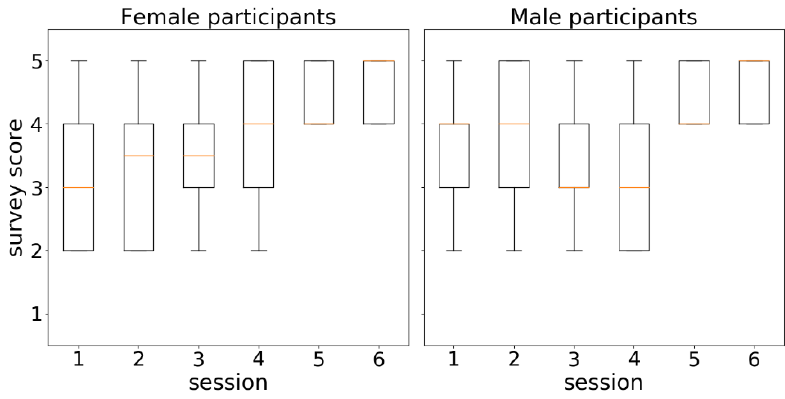
Figure 18. Distributions of survey responses by session from a gender perspective. Table 4. Statistical tests (Mann – Whitney U/Wilcoxon) to assess changes in survey responses over time (sessions 2, 4, and 6). p -values in bold represent significant differences for ⍺ = 0.05. p -Values